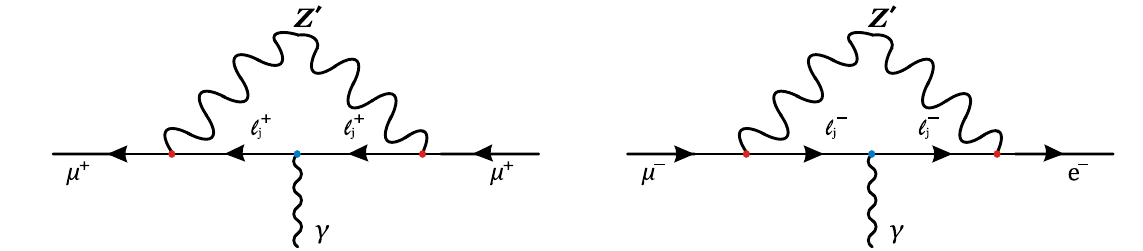
Fig. 3 Left side: Contribution of a non-universal Z (cid:2) boson into the magnetic moment of (anti)muon. Right side: Contribution to the decay, μ − → e − γ . Any of the three (anti)leptons ( j = e ,μ,τ ) could run in to the loop due to the non-universal charges under the extra U ( 1 ) symmetry